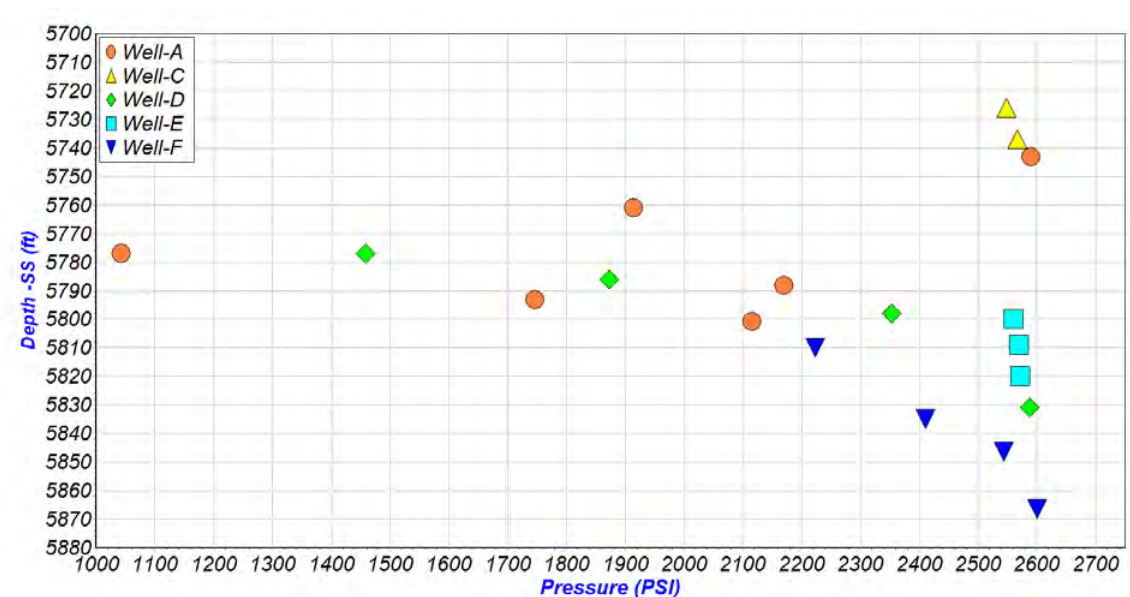
Figure 4. Upper Bahariya reservoir pressure